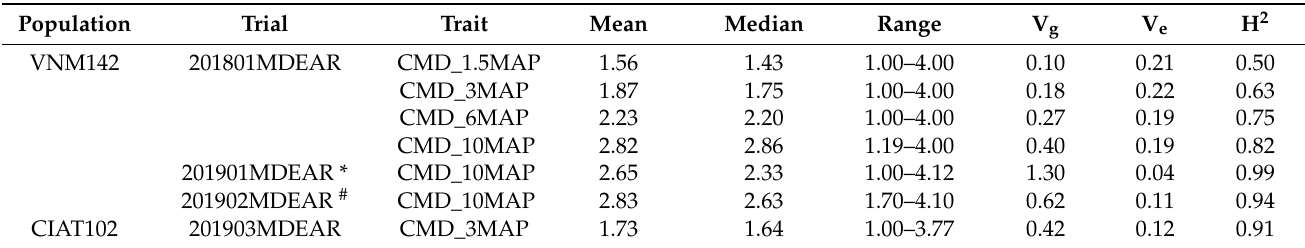
Table 1. Variation in CMD severity of the VNM142 and CIAT102 populations in two growth seasons, 2018–2019 and